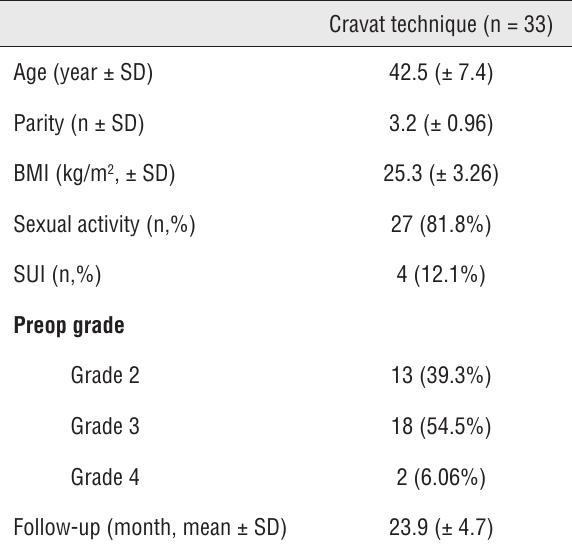
Table 1 - The demographic characteristics of patients.